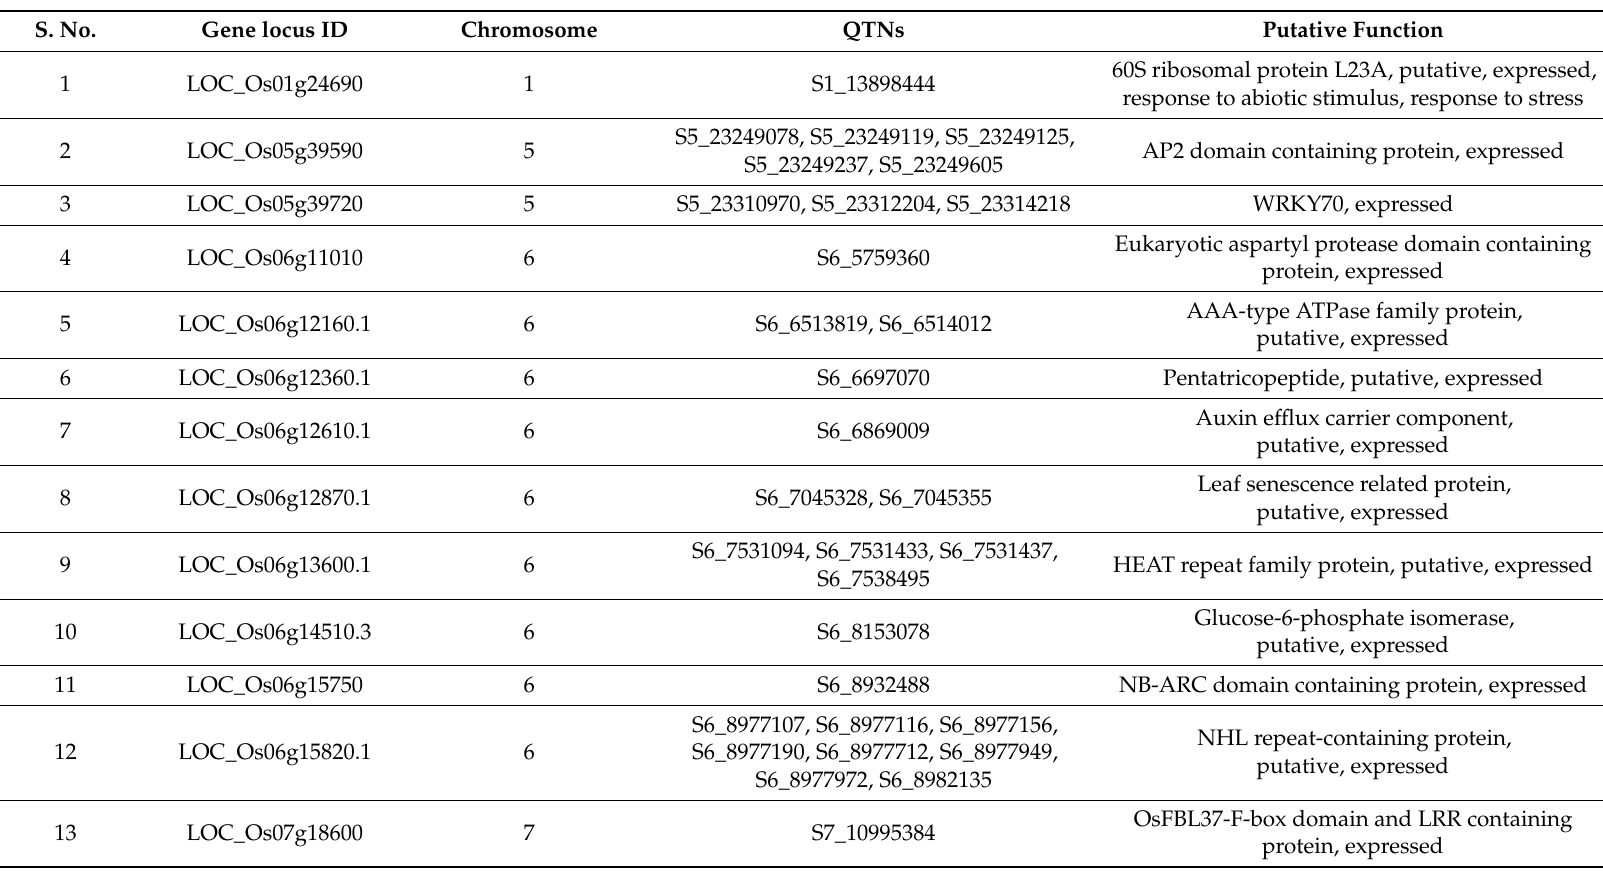
Table 3. Quantitative Trait Nucleotides (QTNs) and associated genes identified with defense-responsive mechanisms. S.